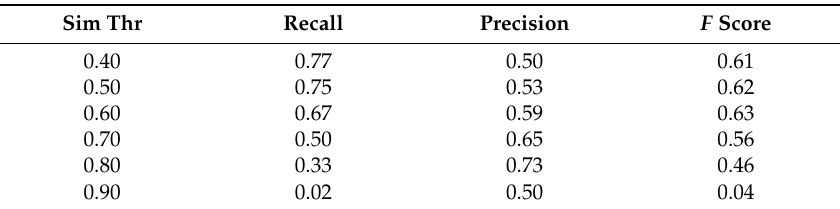
Table 2. Results for different similarity thresholds.